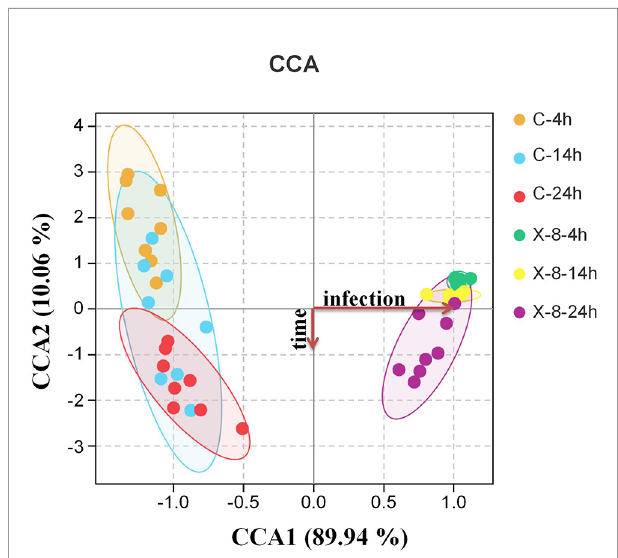
FIGURE 3 | Canonical correspondence analysis (CCA) biplot of epibacterial communities associated with control and infected groups at each time point based on Bray-Curtis distance. C, control group; X-8, PpX-8 infected group. 4 h, 14 h and 24 h were sampling time points.